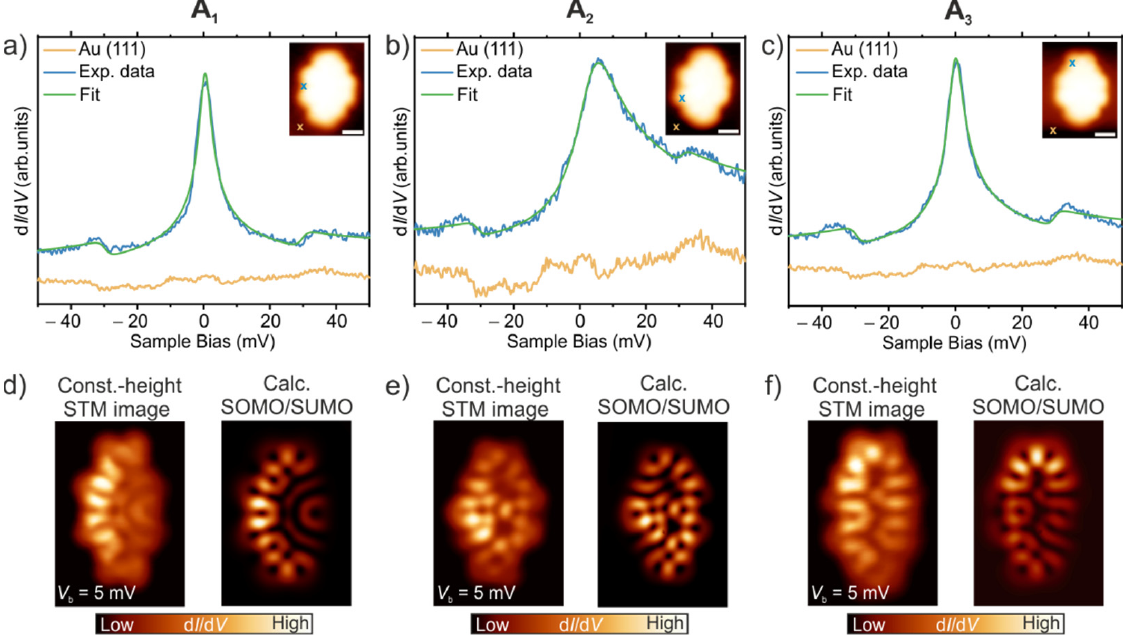
Figure 3. Open-shell character of A 1 – A 3 . ( a – c ) Short-range d I /d V spectra acquired at specific locations of A 1 – A 3 . The blue curves display the experimental data, and the green curves the corresponding Frota function fit. Orange curves depict the reference d I /d V spectra acquired on Au(111). Open feedback parameters: V b = − 50 mV, I t = 450 pA, V rms = 2 mV. ( d – f ) Constant-height STM images acquired at low bias voltages ( V b = 5 mV, I t = 30 pA) and their comparison with the corresponding DFT-calculated maps of the SOMO/SUMO.